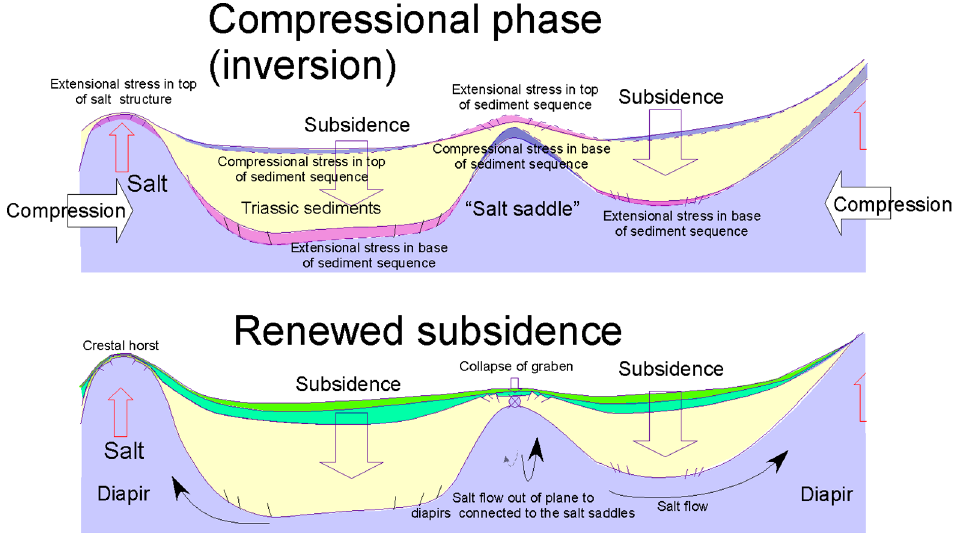
Figure 7. Principle sketch showing how a compressional stress regime would affect basins, salt saddle and diapir area. Extensional stresses above the saddle area act as a hinge between subsiding basins. Extensional faults will follow the length axis of the saddle areas and could collapse when compression ceases and renewed subsidence occurs. This could also explain the existence of crestal horsts seen on the major salt structures (Figure 8).